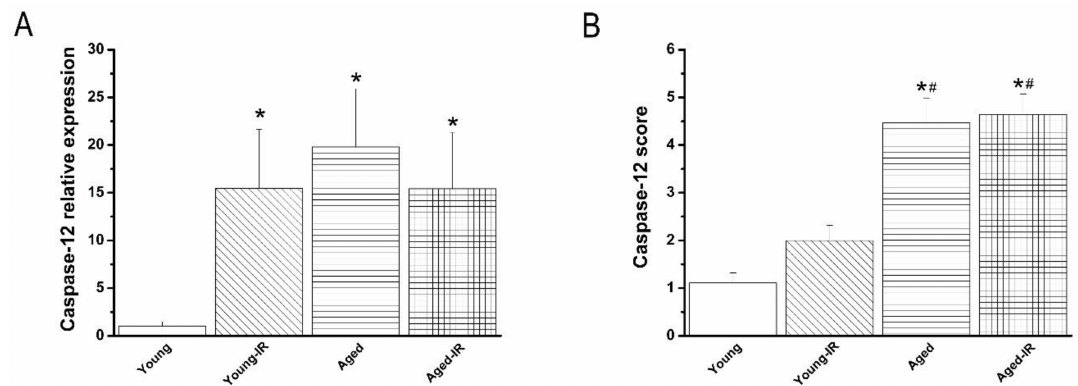
Figure 3. Effect of ischemia/reperfusion (IR) injury on caspase-12 expression. Caspase-12 ( A ) mRNA expression and ( B ) immunoreactivity in the aorta in young and 15-month-old rats. Data are represented as mean ± SEM. * p < 0.05 vs. young, # p < 0.05 vs.